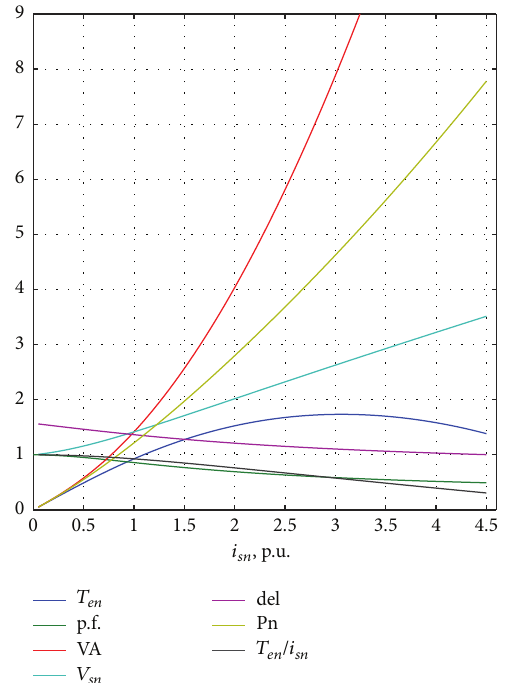
Figure 7: Performance characteristics of constant mutual air gap flux linkages control for IMPMSM.